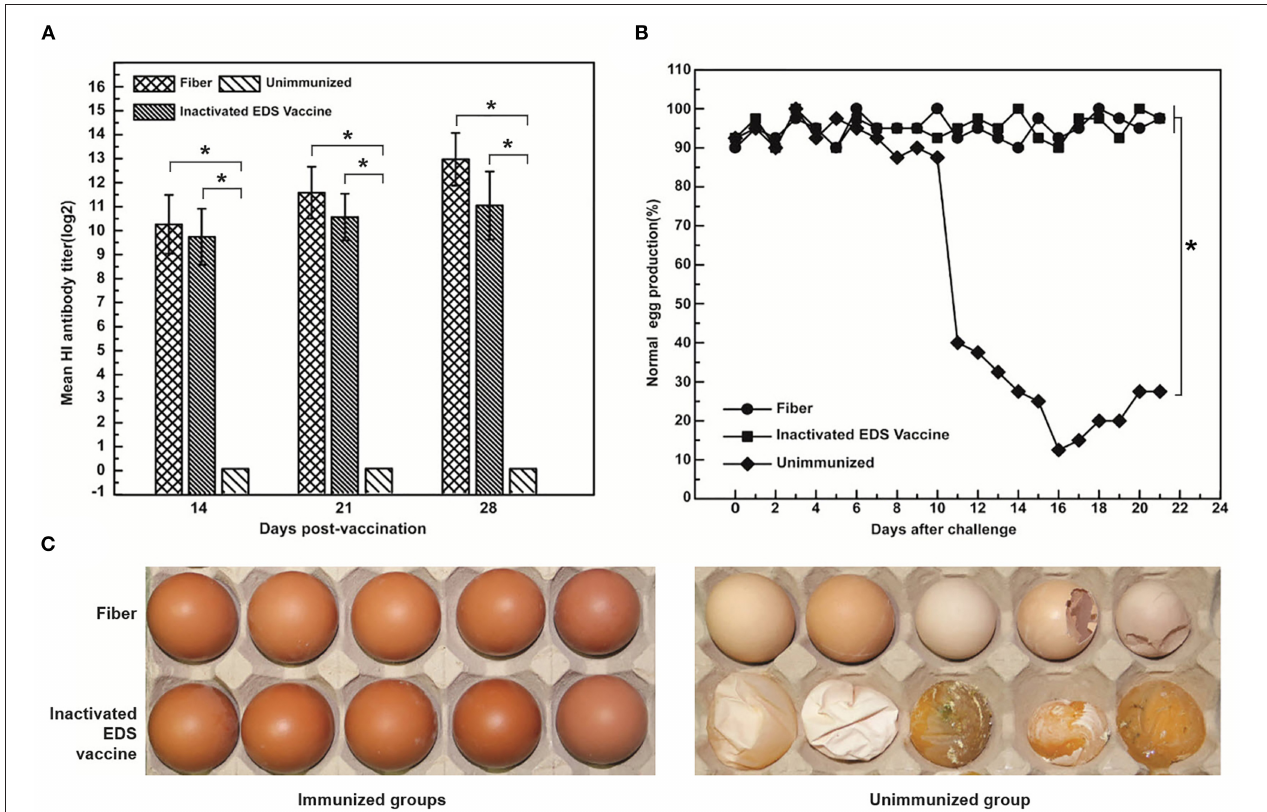
FIGURE 2 | Assessment of vaccine efficiency in laying hens. (A) HI titer of the serum samples at 14, 21, and 28 dpi. (B) Egg production rate of the immunized laying hens after challenge with DAdV-1. (C) Comparison of normal eggs with pale, thin-shelled, shell-less, or soft eggs. The titers of antibodies are expressed as mean ± SD. Asterisk denotes a statistically significant difference ( p <